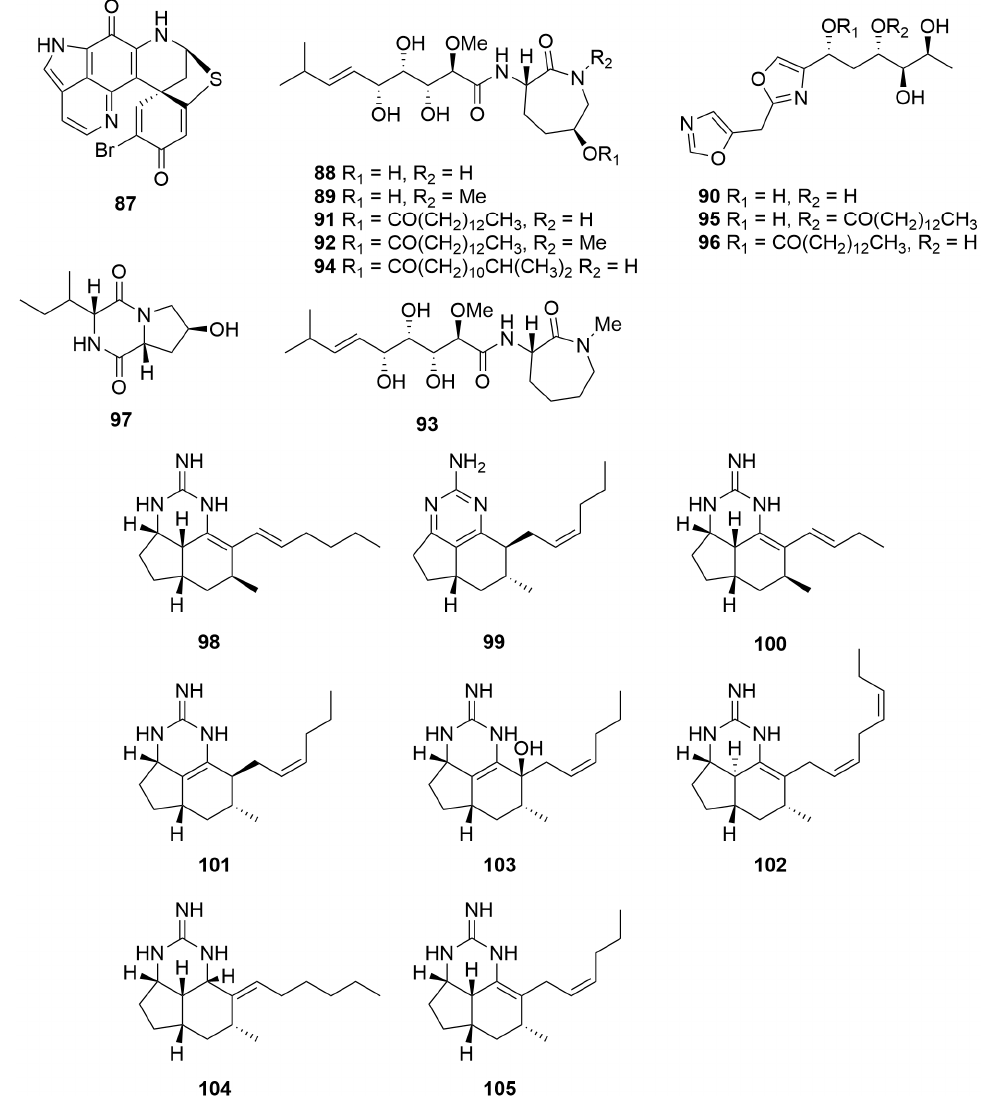
Figure 6. Compounds 87 to 105